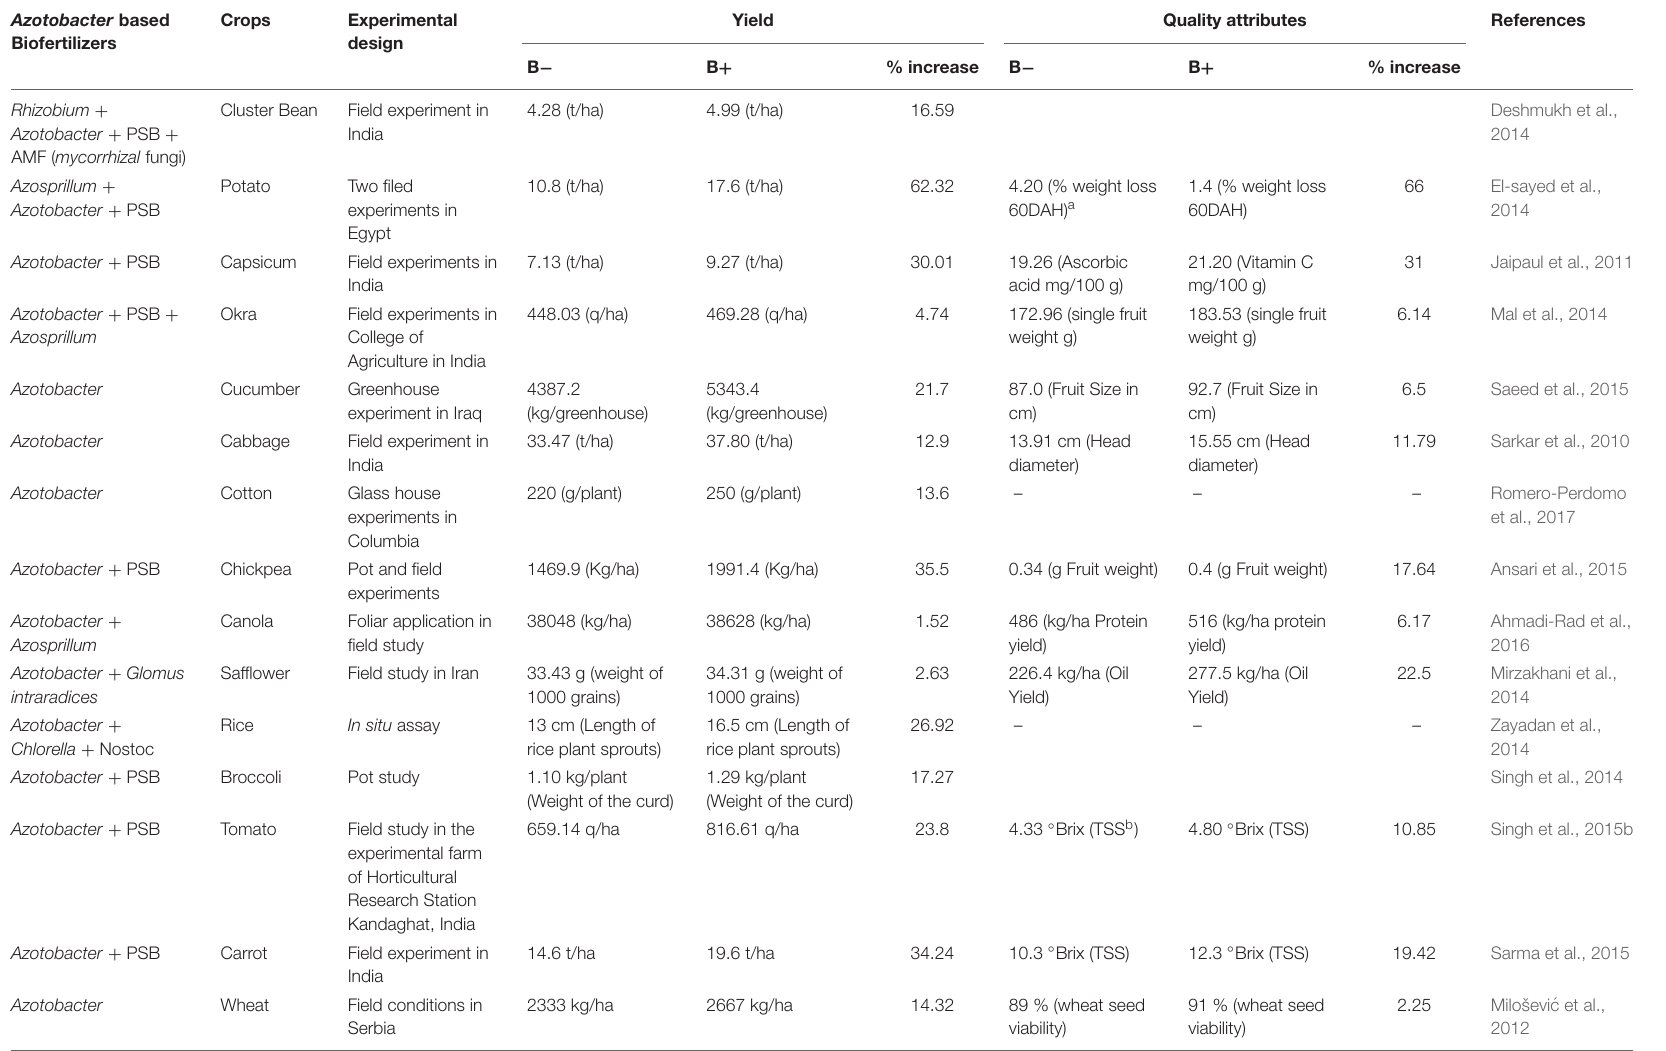
TABLE 1 | Effect of Azotobacter based biofertilizers on yields and quality improvement of different crops. Azotobacter based Biofertilizers